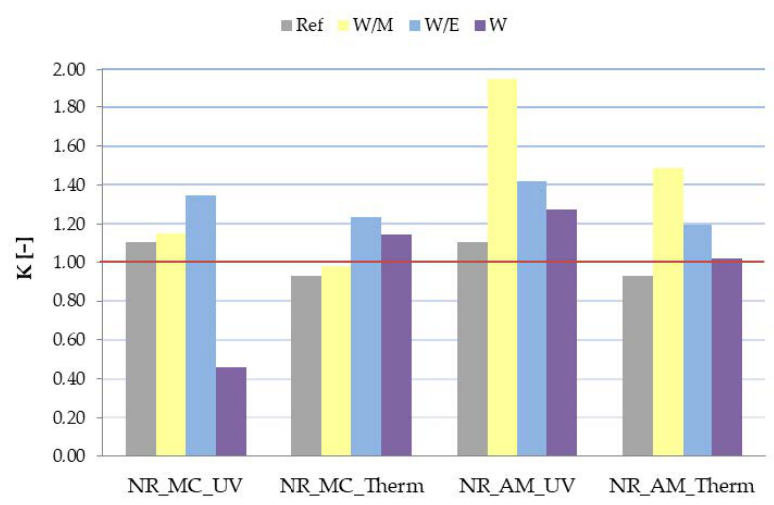
Figure 10. Aging factor (K) of samples after ultraviolet (UV) and thermo-oxidative (Therm) aging.